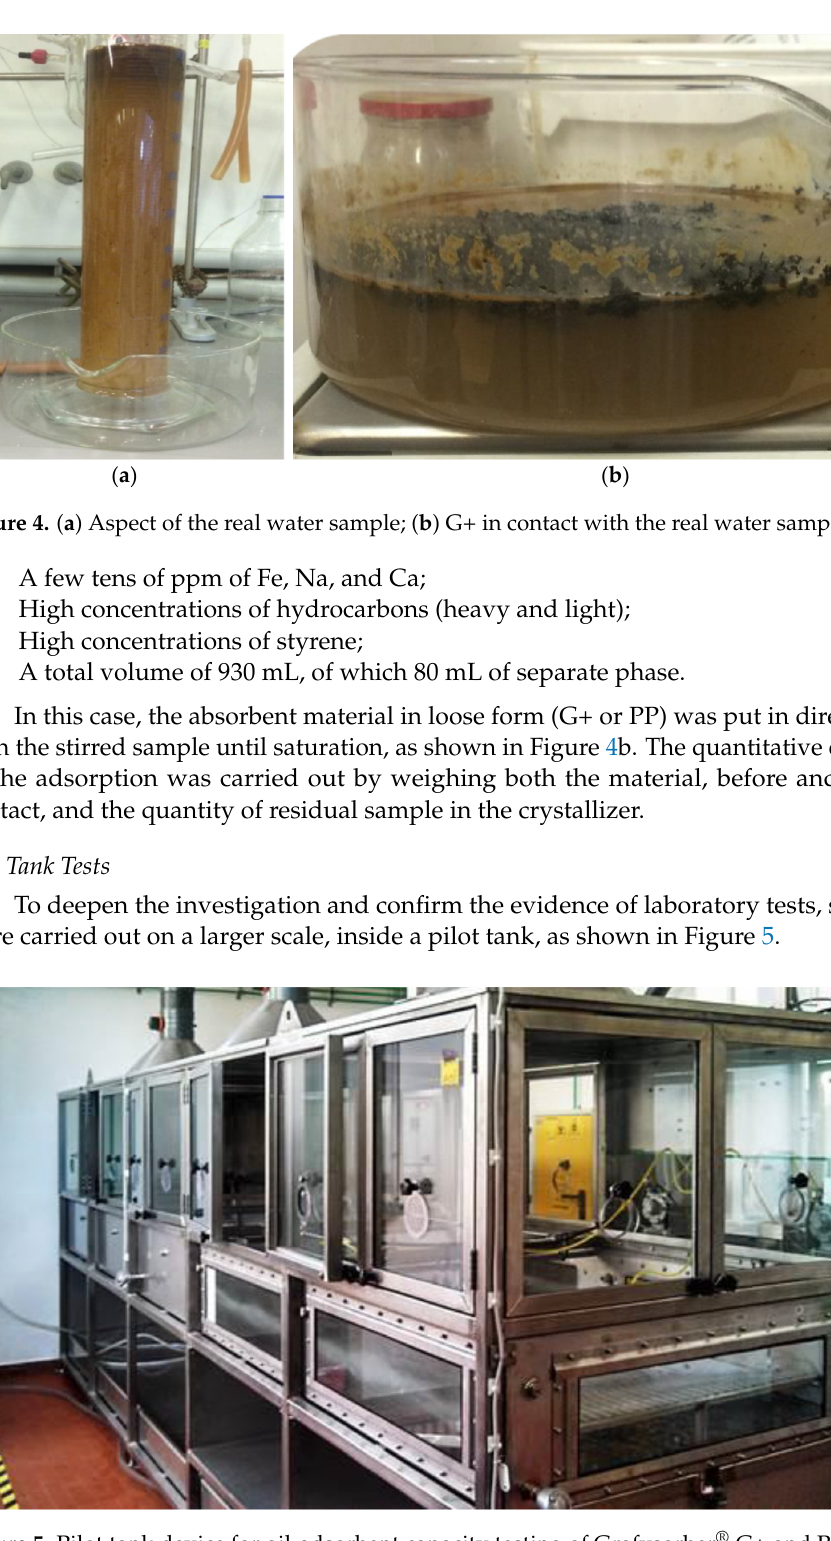
Figure 5. Pilot tank device for oil-adsorbent capacity testing of Grafysorber ® G+ and PP booms in dynamic conditions.